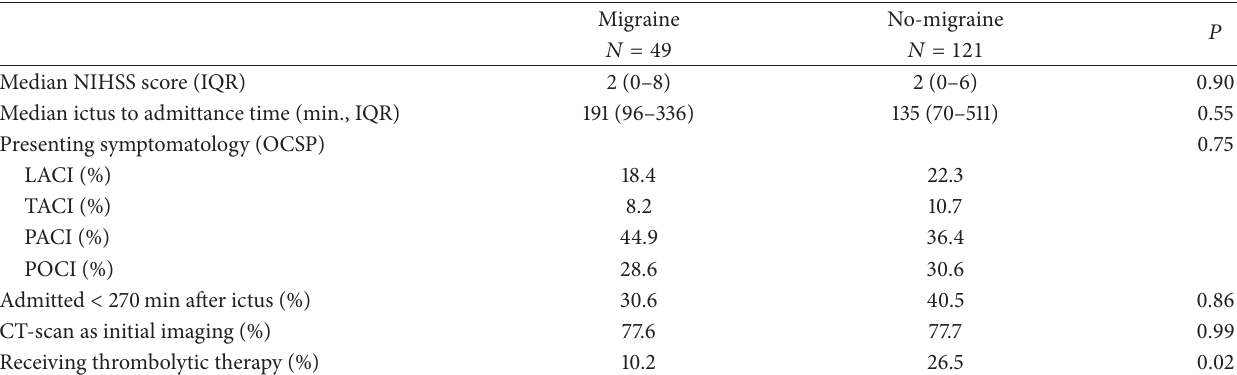
Table 2: Clinical characteristics and initial management of young ischaemic stroke patients with and without migraine.